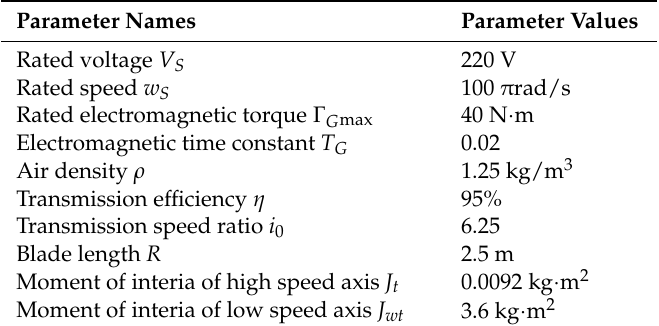
Figure 2. Overall block diagram of fault-tolerant control for the WECS.